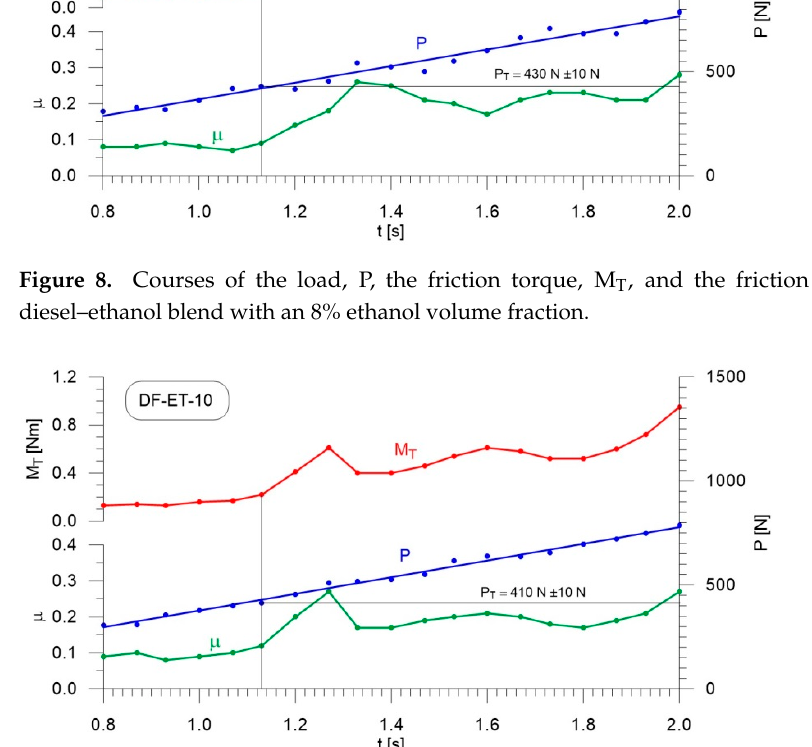
Figure 9. Courses of the load, P, the friction torque, M T , and the friction coefficient, µ, for diesel–ethanol blend with a 10% ethanol volume fraction.